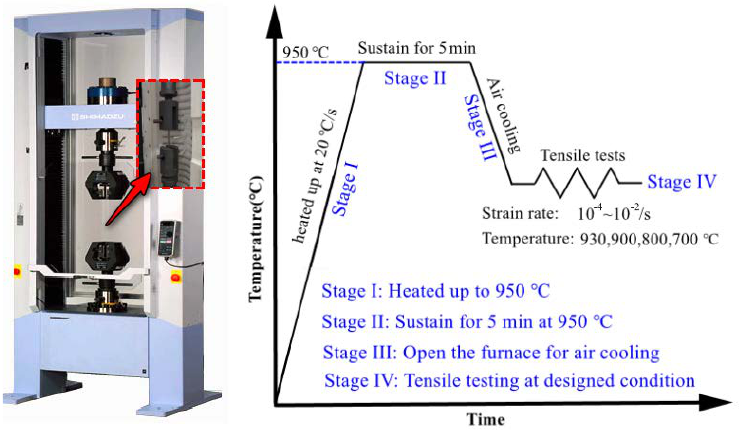
Figure 3. A flow chart for the constant strain-rate tensile test.